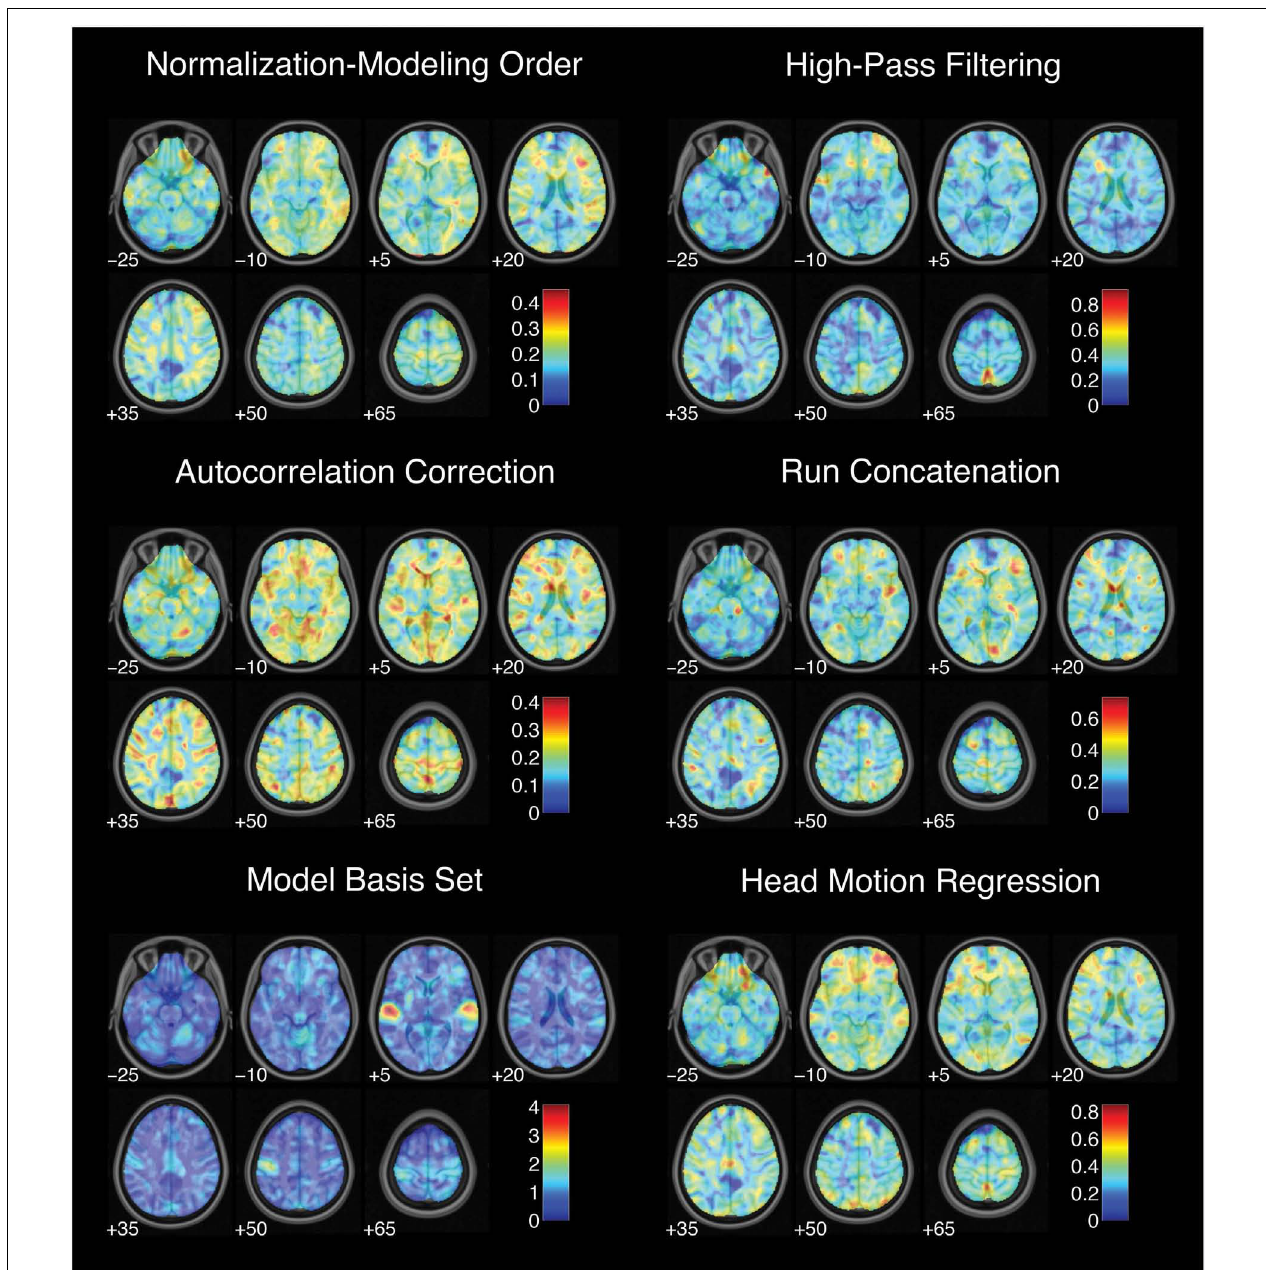
FIGURE 3 |Variation in activation strength attributable to model estimation choices. Images are presented in neurological orientation, with the left hemisphere displayed on the left. Note that color scales differ across